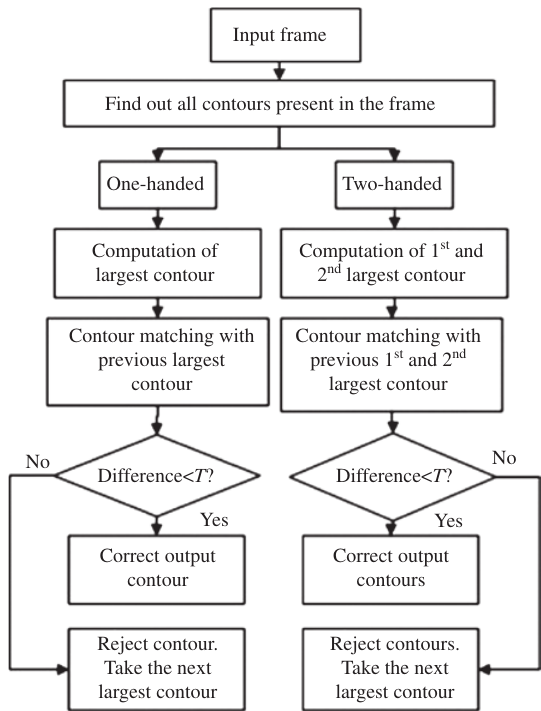
Figure 2: Flowchart of the Contour Processing